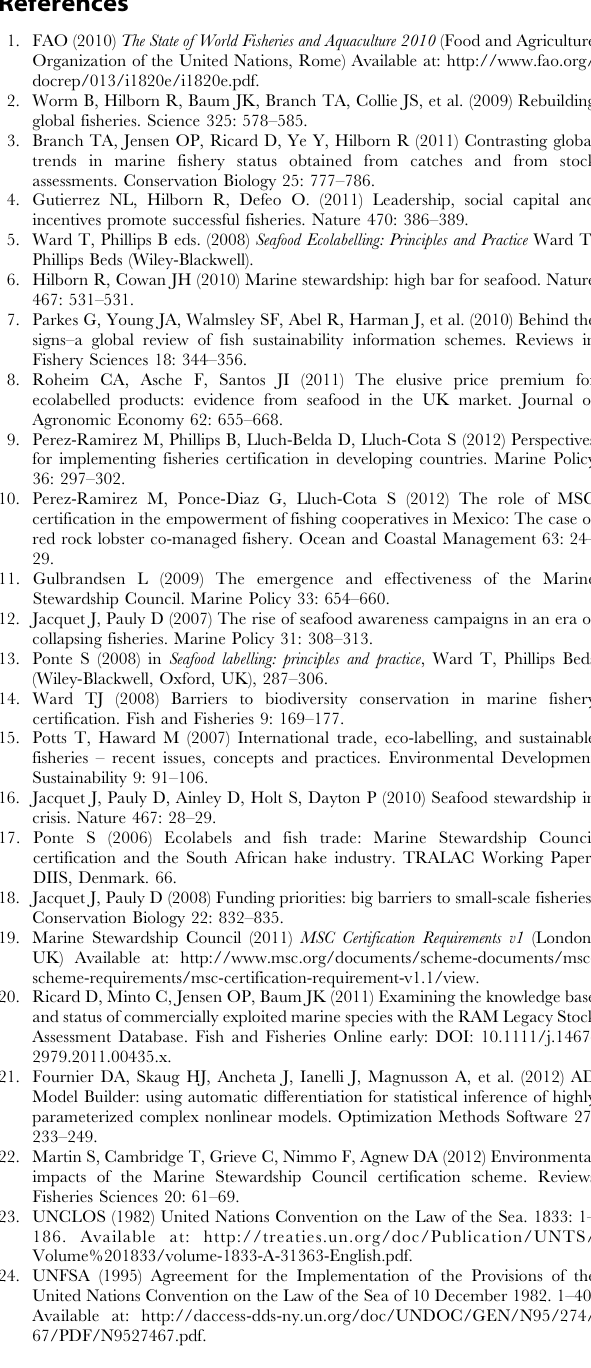
Table S5 Results of test for difference in mean B/B MSY over time between certified and uncertified stocks. *denotes significance (* P , 0.05; ** P ,